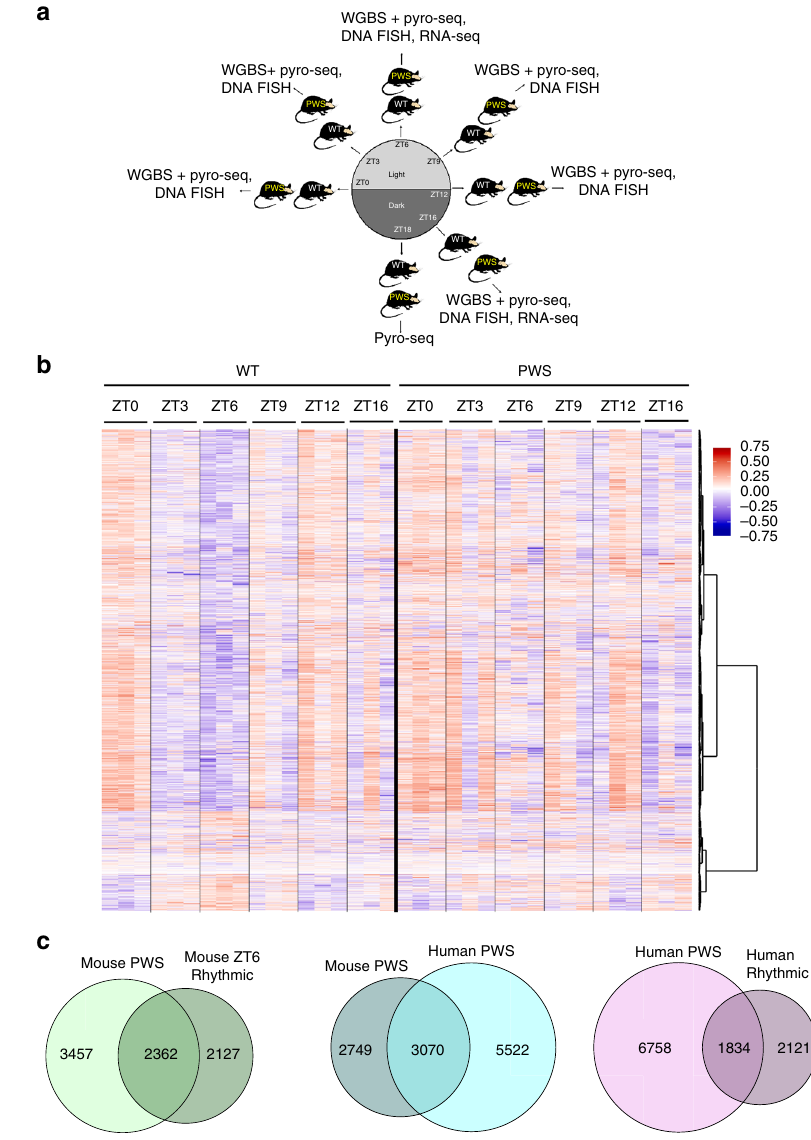
Fig. 1 Diurnal rhythmic oscillations of DNA methylation are disrupted by loss of Snord116 . a Overview of diurnal experimental design. All experiments were performed on male cerebral cortex. WGBS n = 3 WT ZT0, 3 WT ZT3, 3 WT ZT6, 3 WT ZT9, 3 WT ZT12, 3 WT ZT16, 3 PWS ZT0, 3 PWS ZT3, 3 PWS ZT6, 3 PWS ZT9, 3 PWS ZT12, 3 PWS ZT16; RNA-seq n = 3 WT ZT6, 2 WT ZT16, 2 PWS ZT6, 2 PWS ZT16; DNA FISH n = 3 WT ZT0, 3 WT ZT3, 3 WT ZT6, 3 WT ZT9, 3 WT ZT12, 3 WT ZT16, 3 PWS ZT0, 3 WT ZT3, 3 PWS ZT6, 3 WT ZT9, 3 PWS ZT12, 3 PWS ZT16; pyrosequencing n = 3 WT ZT0, 3 WT ZT3, 3 WT ZT6, 3 WT ZT9, 3 WT ZT12, 3 WT ZT16, 3 WT ZT18, 3 PWS ZT0, 3 PWS ZT3, 3 PWS ZT6, 3 PWS ZT9, 3 PWS ZT12, 3 PWS ZT16, 3 PWS ZT18. b Heat map of WT ZT6 diurnal DMR methylation for WT and PWS cortex. Hyper-methylation (red) and hypo-methylation (blue) respective to the average WT methylation across all diurnal time points. c Overlapping genes associated with PWS-speci fi c DMRs and WT rhythmic DMRs in mouse, PWS- speci fi c DMRs in mouse versus human postmortem brain, and human PWS-speci fi c DMR versus human rhythmic from postmortem brain. Methylation data from human postmortem brain was obtained from previously published datasets, GSE81541 (PWS and WT) and https://www.synapse.org/#! Synapse:syn3157275